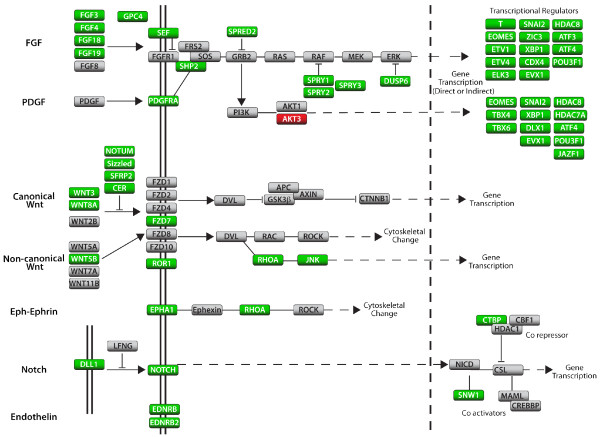
Changes in mRNA levels among various signalling pathway members following inhibition of FGFR activity. Representative aspects of each pathway are presented to illustrate FGFR dependent changes in gene expression. Genes shown in green require FGF signalling for expression. Genes shown in gray are expressed in the primitive streak but expression is not dependent on FGF signalling. Red are genes upregulated following FGF signalling inhibition.